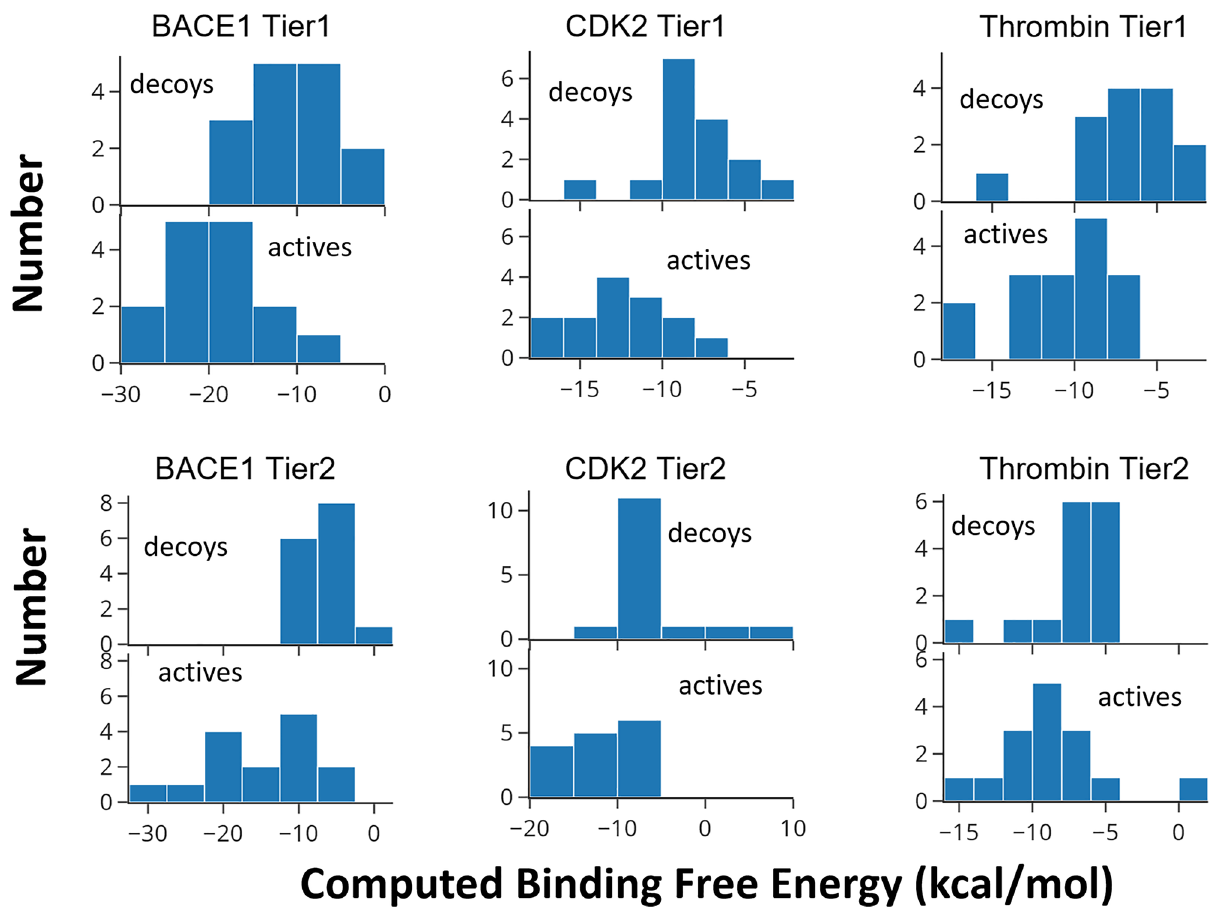
Figure 2. Comparison of distributions of computed ABFE values for inactive (decoy) and active compounds for Tier 1 and Tier 2 of all three protein targets, as labeled.